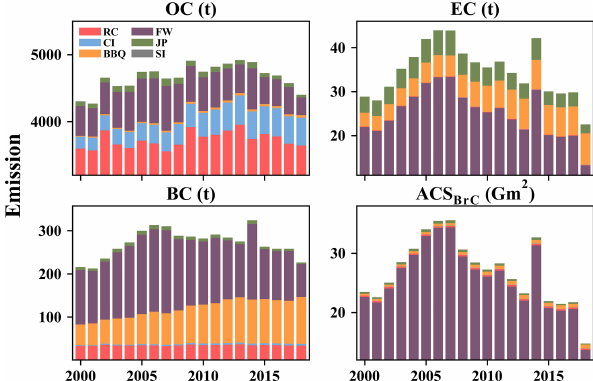
Figure 3. The total consumption of the FMSs in China during 2000–2018. The abbreviations used in the figure are as follows: SI – sacrificial incense, JP – joss paper, FW – fireworks, PK – pork, BF – beef, LB – lamb, and CK – chicken.